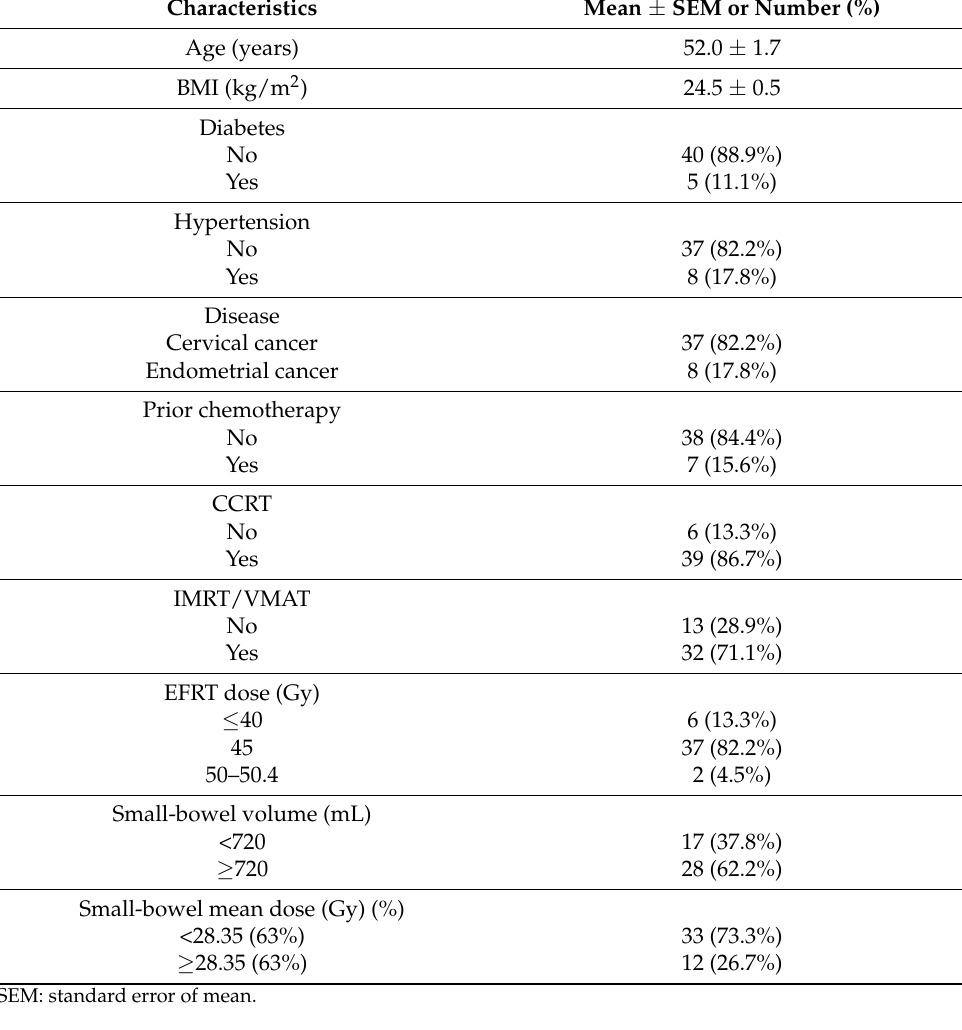
Table 1. Characteristics of patients ( n = 45).